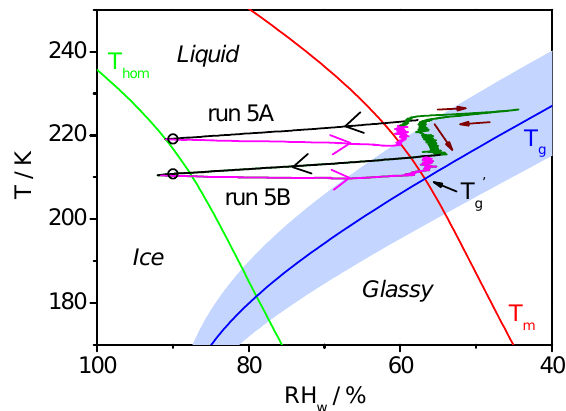
Fig. 14. Experimental trajectories of expansion runs 5A and 5B as a function of RH w . T g denotes the glass transition temperature, T m the ice melting temperature, and T hom the homogeneous freez- ing temperature. The same colour code as in the bottom panel of Fig. 7 is used to underline the temporal order of the experiment. The circles denote the onsets of ice nucleation during the expan- sion runs, whose further AIDA records are shown in Fig. 13. The fit parameters of the water activity measurements for raffinose/M5AS solutions of different concentrations, not included in Table A4 of Zobrist et al. (2008), were obtained from the authors upon re- quest. They are: a= − 1, b= − 0.93366, c=0.14602, d=0.0027723, e= − 0.0049331, f= − 0.0037756, and g=0.0059027. Together with the parameterisation of T g as function of the raffinose/M5AS weight fraction, the curve of the glass transition temperature (blue line) and its uncertainty estimate (blue shaded area) were computed. Note that for Exp. 4, both the trajectories of run 4A and run 4B approxi- mately fall into the regime of that of run